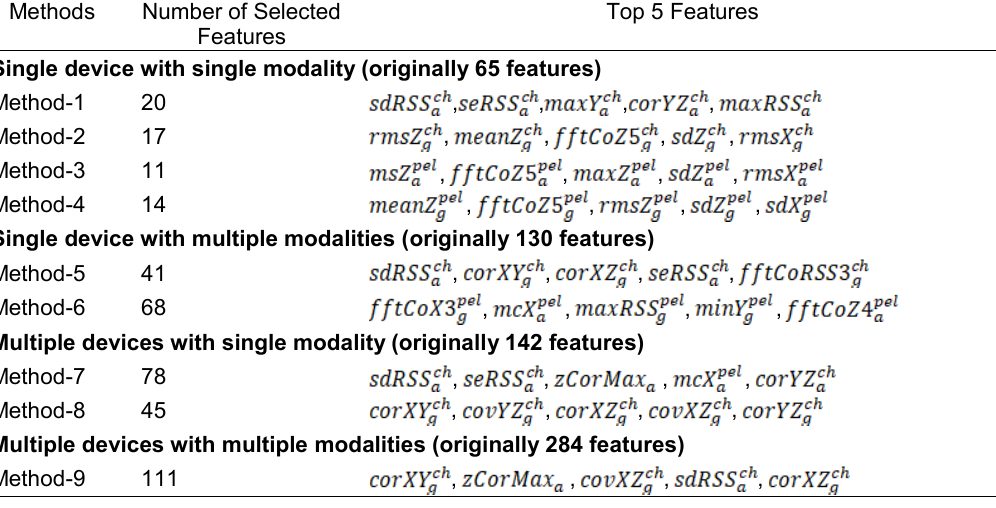
Table 5. Features selection in different methods for pelvis